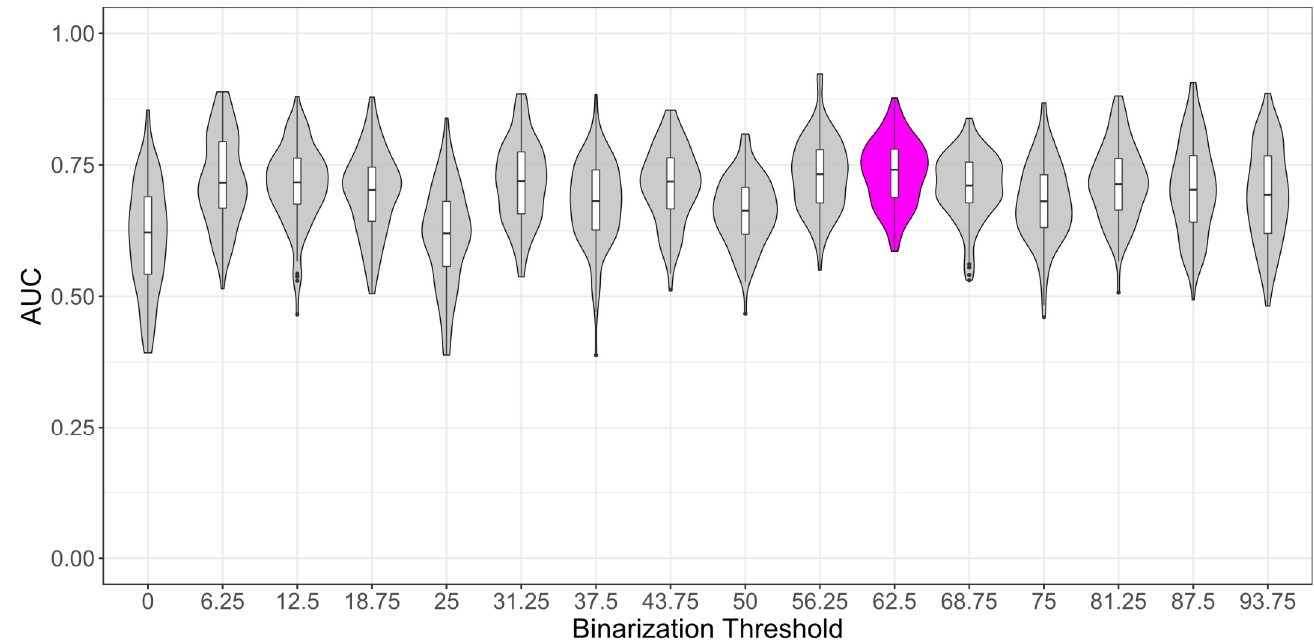
Figure 8. AUC from multiple binarization thresholds, dividing samples into classes according to their L. polyphyllus coverage. Highest mean AUC was achieved by the classification model that divided the two classes at 62.5% L. polyphyllus coverage. Boxplots represent AUC values from 100 model